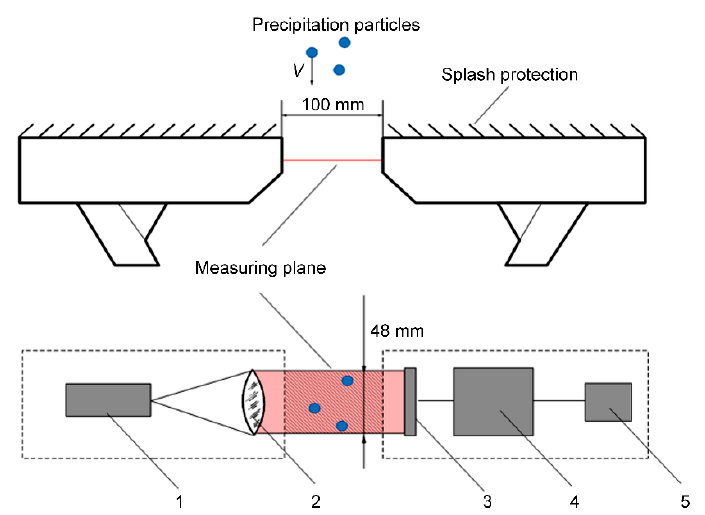
Figure 2. Functional scheme of the optical rain gauge OPTIOS: 1 is an optical radiation source; 2 is an optical lens system; 3 is linear optical sensor; 4 is forming unit of measured data; 5 is output interface.